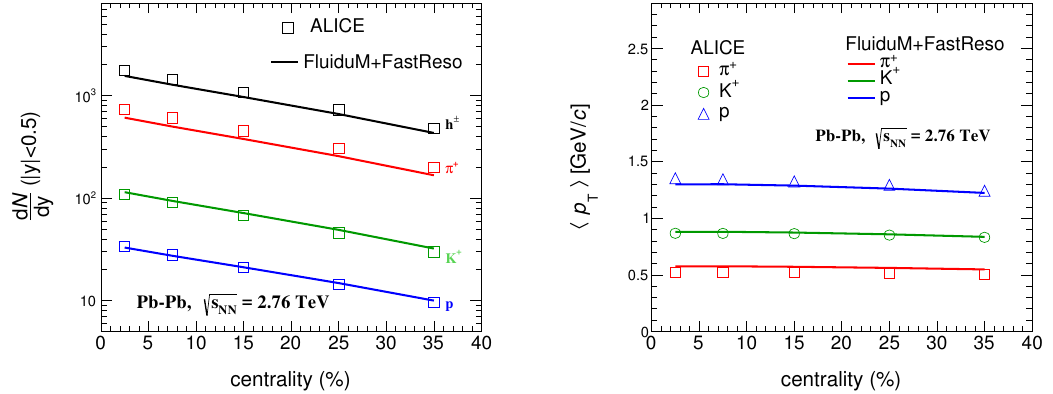
Figure 4 . Mid-rapidity densities d N= d y (for j y j < 0.5) for charged hadrons h (cid:6) , pions (cid:25) + , kaons K + and protons p (top panel) and mean- p T (bottom panel) as functions of centrality from the calculation in comparison with the ALICE experimental measurements [36, 51].